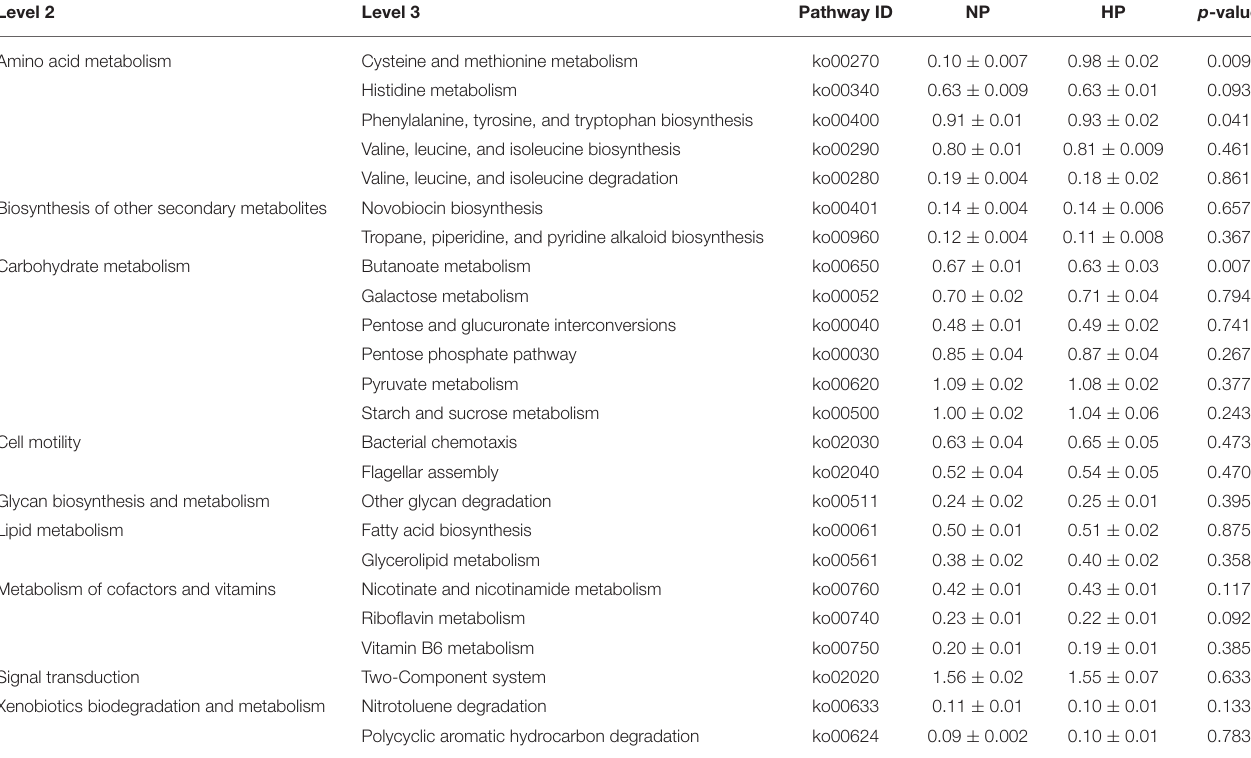
TABLE 2 | KEGG pathways that showed different abundances between the cecal digesta microbiota of goats fed with NP a and HP b